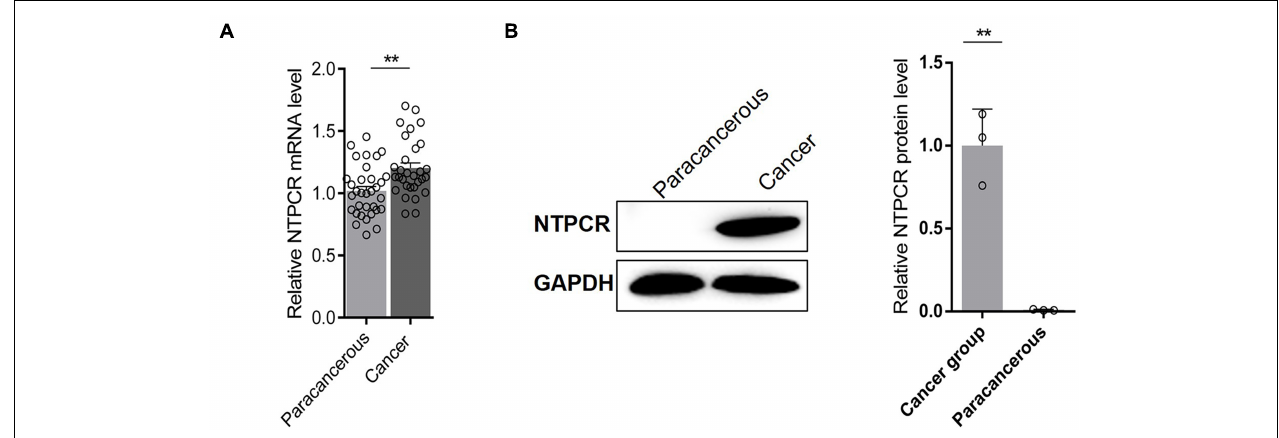
FIGURE 1 | Via (A) RT-qPCR analysis and (B) Western blot analysis, the expression of NTPCR in cancer tissues was significantly increased compared to para-cancerous tissues (** p < 0.01).